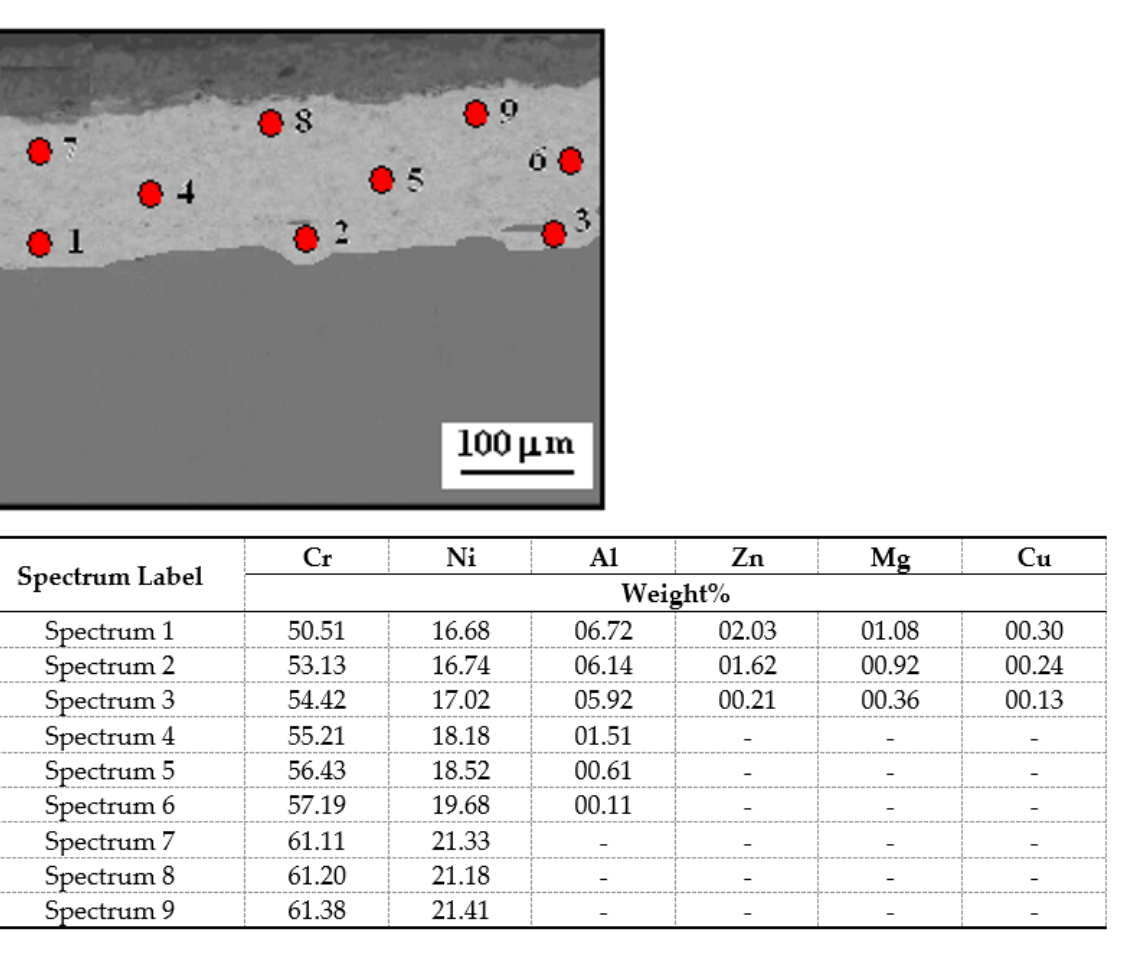
Figure 7. SEM image cross-section of the Cr 3 C 2 -25(Ni20Cr) cermet coating on the Al7075 substrate after laser remelting for the spot speed of 800 mm/min, and the results of point X-ray microanalysis of the chemical composition of the tested material.